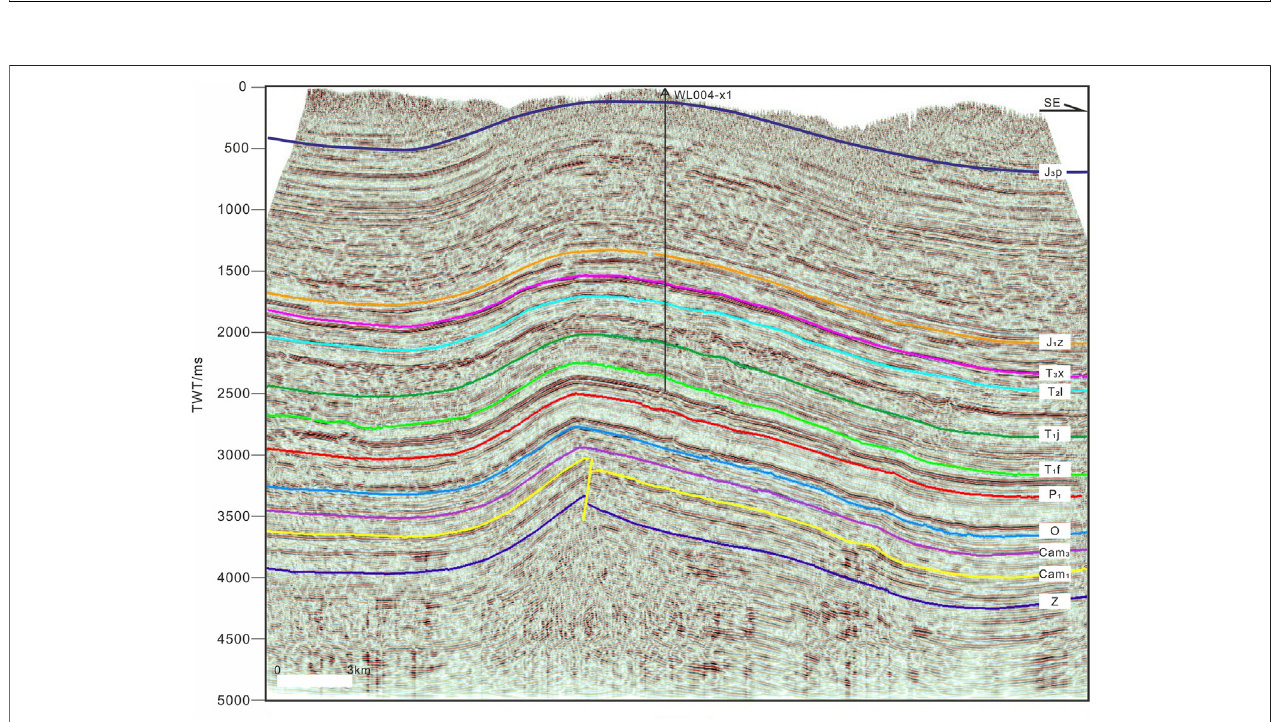
FIGURE 10 | Seismic pro fi le of the Jiulongshan